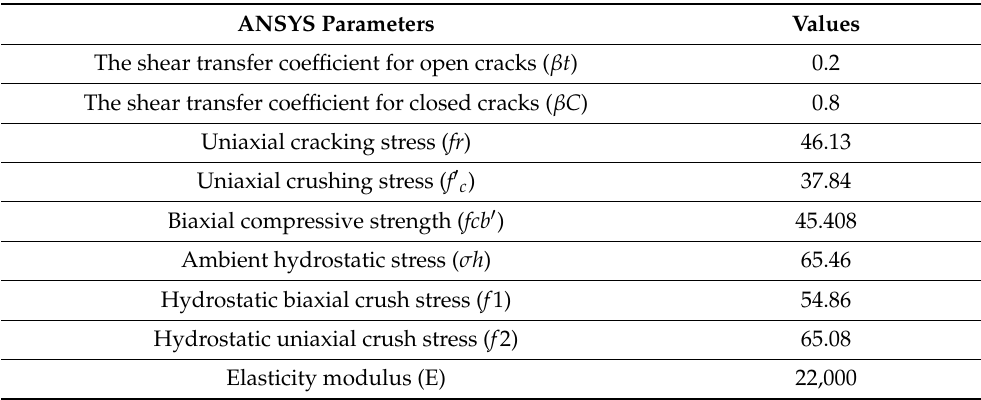
Table 14. Material properties for nonlinear concrete in ANSYS calculated based on experimental results of the present